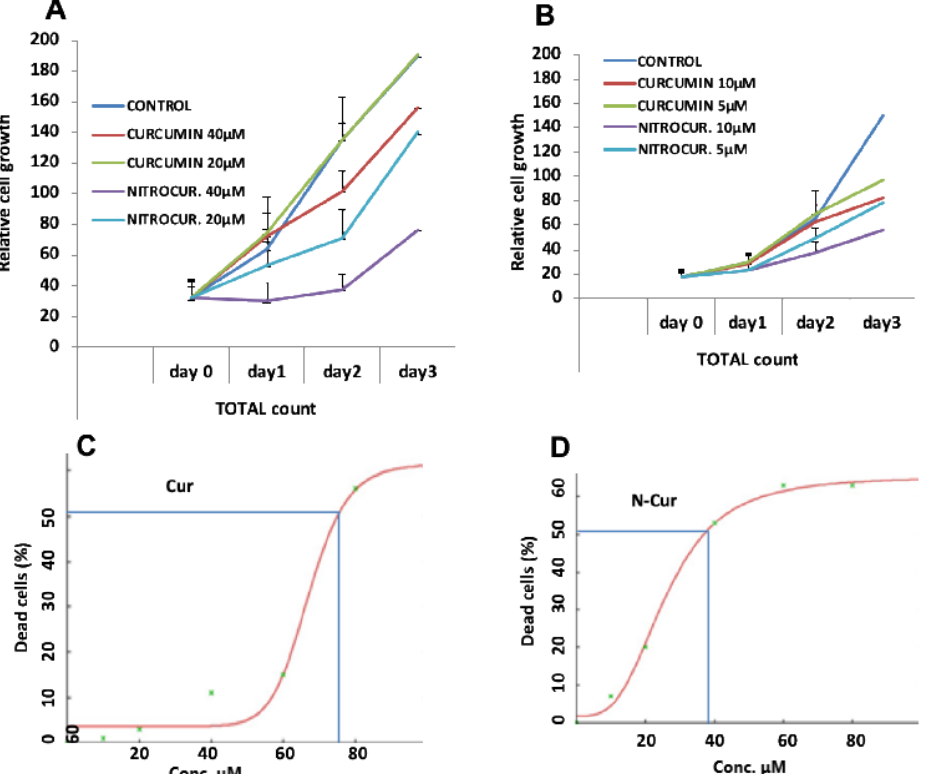
Figure 3. Dose-dependent effect of NO–curcumin on colon cancer cells and IC50. ( A , B ) Representative statistical analysis of the effect of curcumin (cur) and nitro-curcumin (N-cur) on HT29 cell proliferation using an XTT assay after treating the cells with the indicated concentrations. ( C , D ) XTT analysis of cell proliferation after treating HT29 cells with the indicated doses of curcumin ( C ) and nitro-curcumin ( D ) for the indicated time points. The X-axis intersection point with the 50% value on the Y-axis represents the IC50 of each compound as determined by GraphPad Prism statistics software (San Diego, CA,